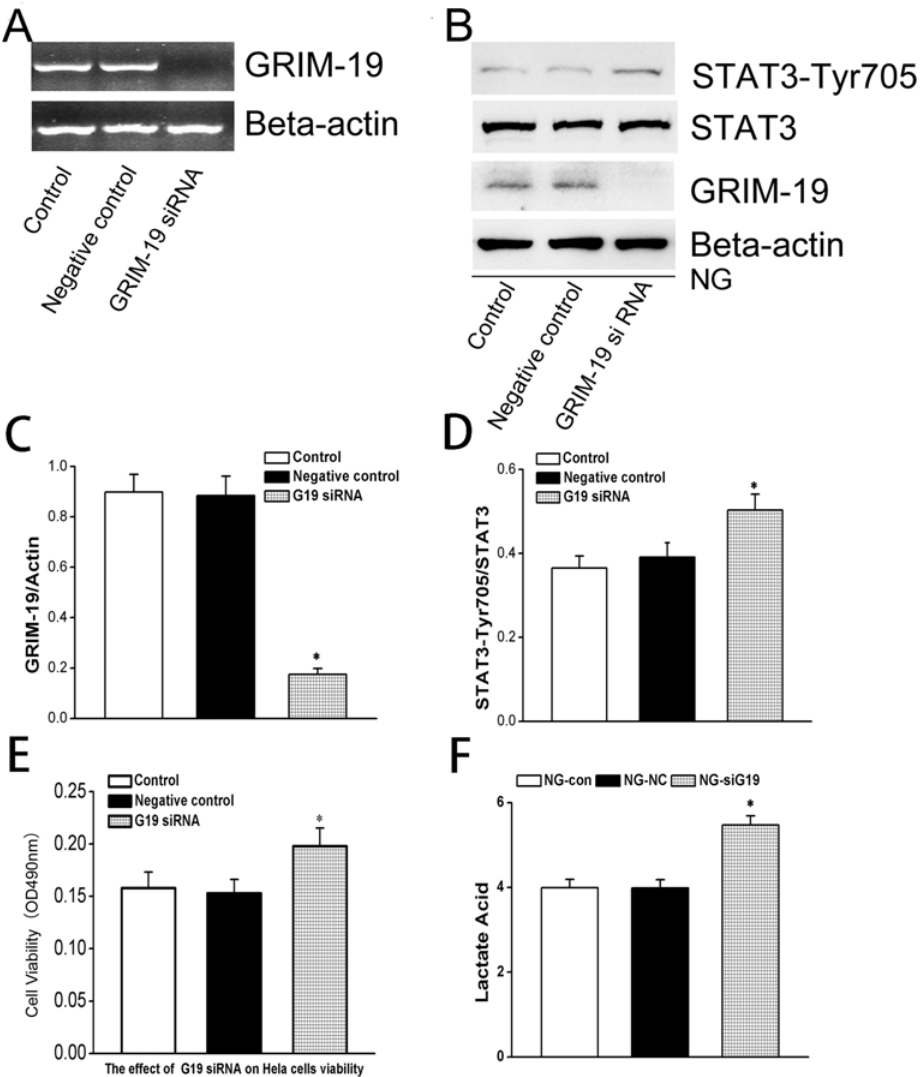
Fig 2. In normal glucose cultured HeLa cells, GRIM-19 was silenced by using siRNA while a scramble served as a negative control. The effects of siRNA were confirmed by RT-PCR with ß-actin serving as a control (panel A). The expression of p-STAT3/total STAT3 and GRIM-19 levels were measured by western blotting (shown in panel B) and quantified in the bar graph for GRIM-19 (C) and p-STAT3 (D) where ß-actin served as a loading control. Again, MTT assay (E) and lactate acid production (F) were performed to demonstrate the effects of knock-down of GRIM-19. Data were obtained from three independent experiments and expressed as mean ± SD. * , denotes a P < 0.05 in comparison with the control